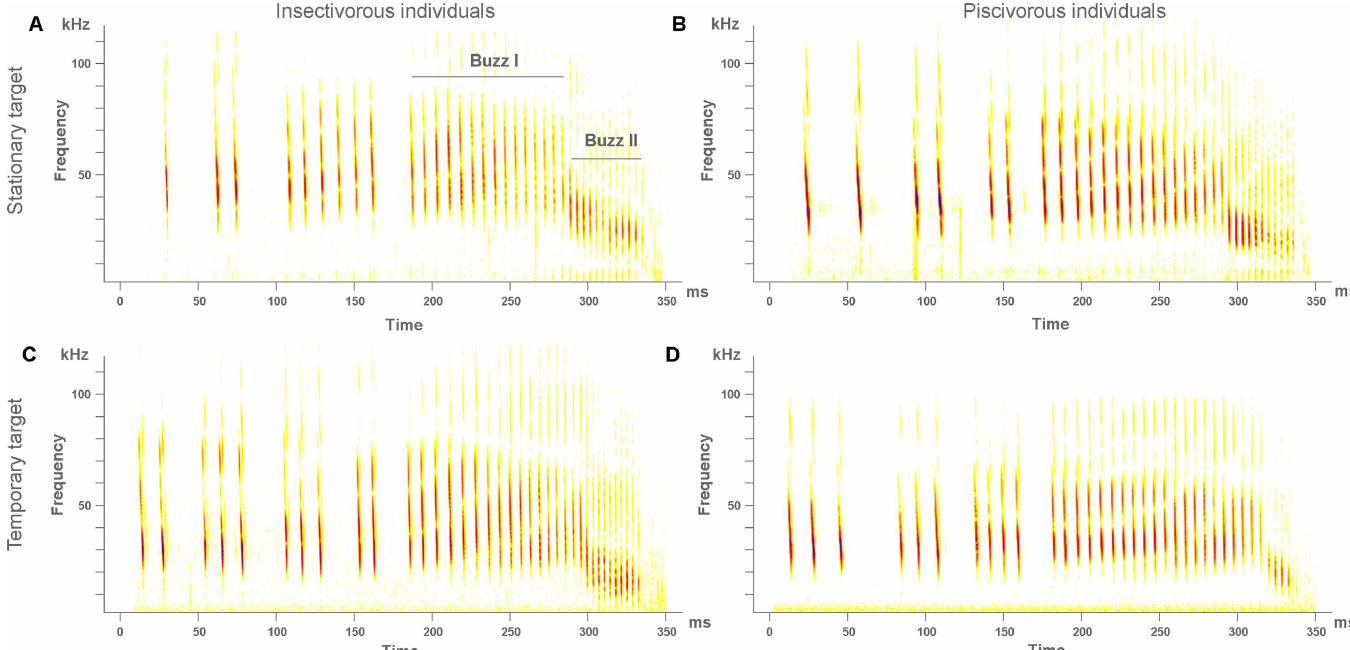
Fig 1. Illustrative spectrograms of the terminal echolocation phase. (A-B) Insectivorous and piscivorous individualsexhibitalmost identicalecholocation patterns when attacking stationary targets. In both cases the number of buzz I pulses is slightly higherthan the numberof buzz II pulses. (C) Insectivorous individualsvary their echolocation pattern minimallywhen attacking temporary targets, maintaining the number of buzz I pulses, and slightly decreasing the number of buzz II pulses. (D) In contrast, piscivorous individuals noticeably decreasethe number of buzz II pulses whileincreasingthe number of buzz I pulses when attacking temporary targets with respect to attacks upon stationary